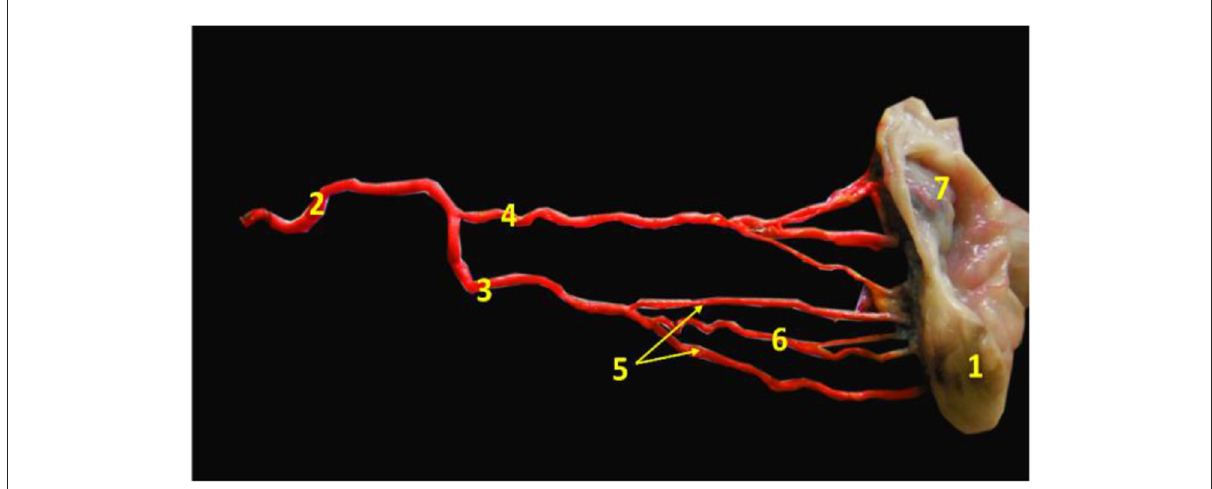
FIGURE3 Image revealed the main ovarian artery of the ovary. 1- ovary, 2- main ovarian artery, 3- ovarian branch of the main ovarian artery, 4- tubal branch of the main ovarian artery, 5- ovarian twigs of the ovarian branch, 6- luteal branch of the ovarian branch, and 7- mesoslphenix.